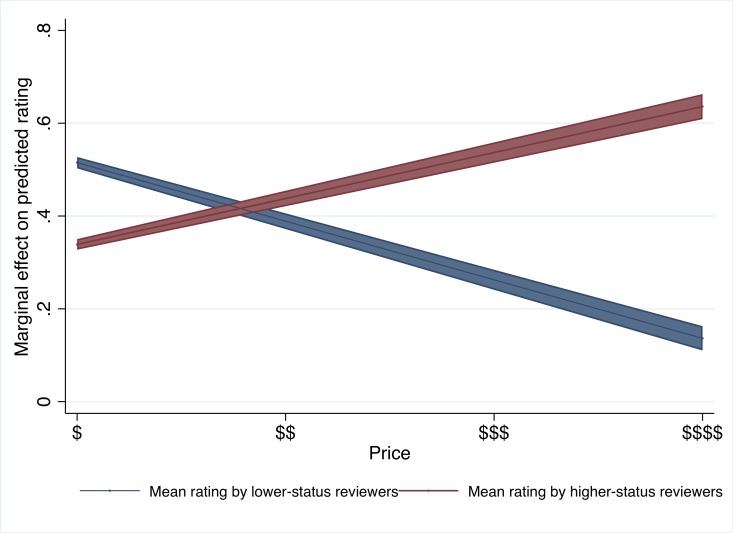
Marginal increase on a focal reviewer’s rating predicted by prior ratings by higher- and lower-class reviewers as a function of the organization’s price level.Study 1: Based on Model 3 in Table 2. The lines represent linear regression estimates, the shaded areas show the 95% confidence intervals.